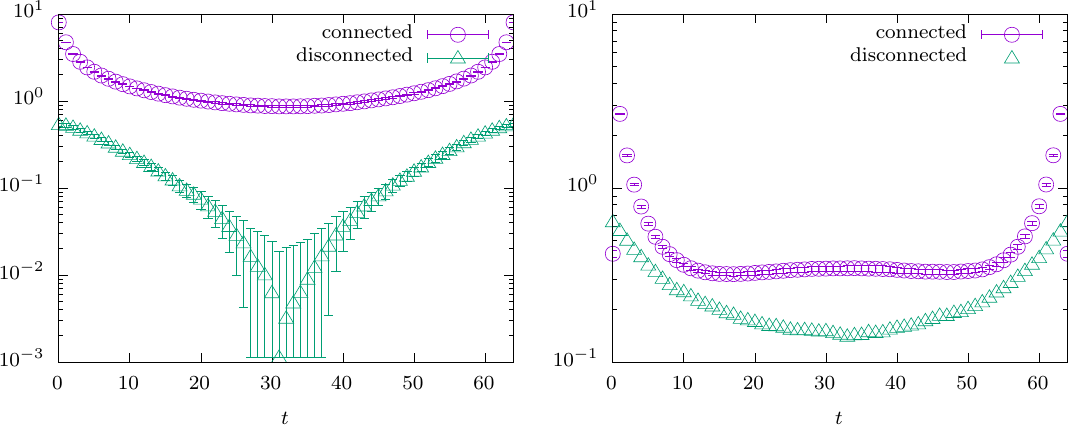
Figure 10. Connected and disconnected part of the (cid:17) -meson (left) and f-meson (right) correlation function C ( t ) as function of the temporal extend t for (cid:12) = 17 and (cid:20) = 0 : 26903.